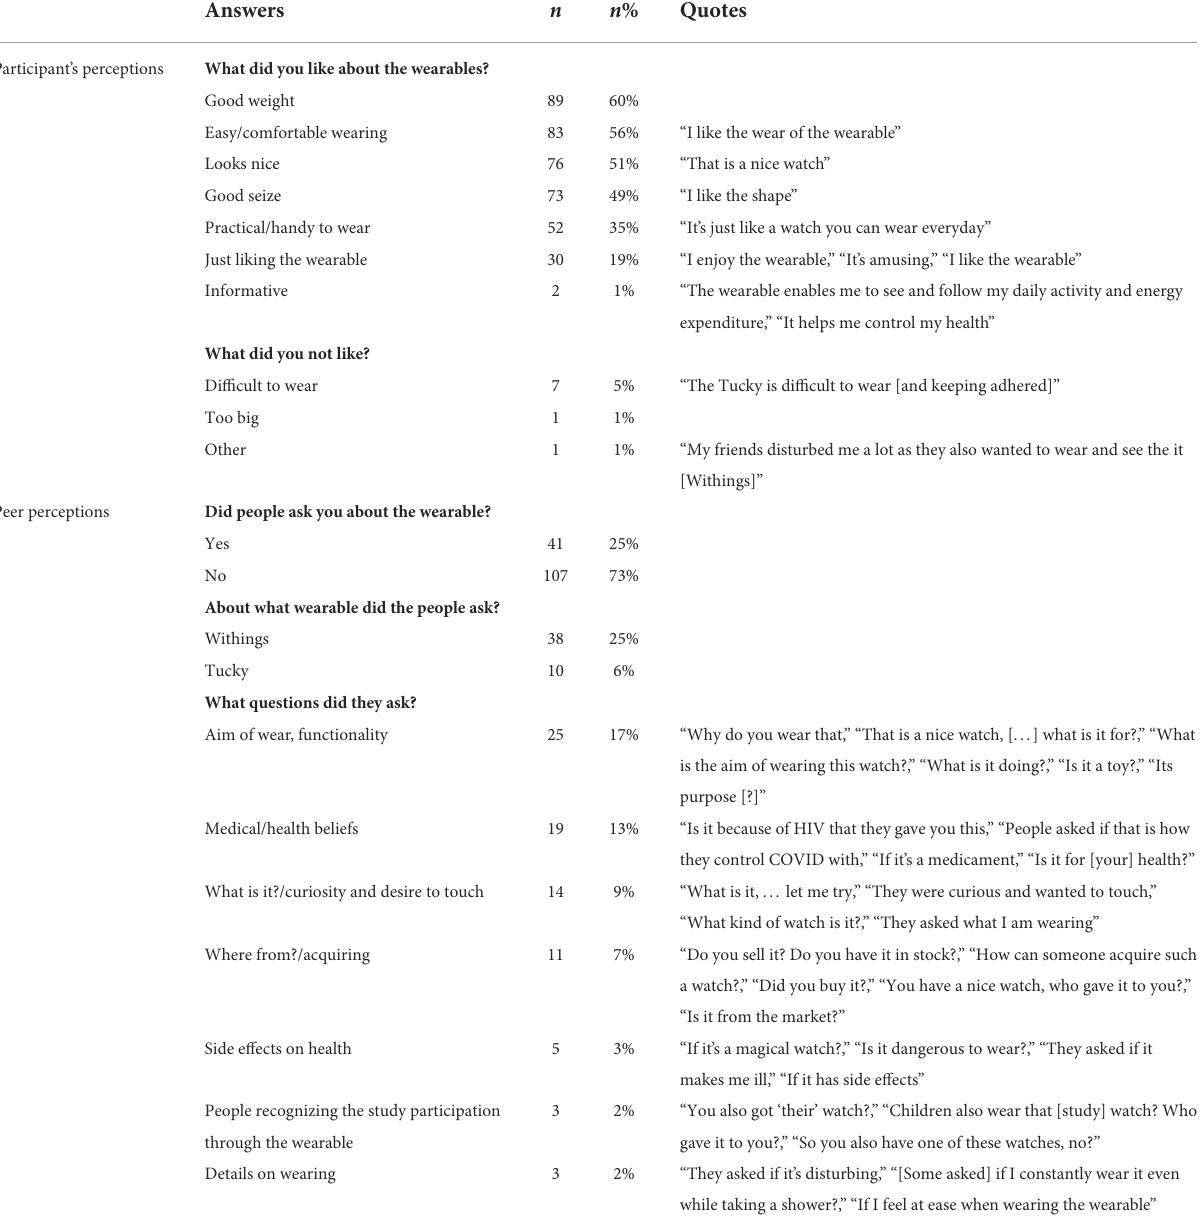
TABLE 3 Overview of key responses to multiple-choice and open-ended questions about perceptions on wearables (of participants and social circle). Answers n n % Quotes Participant’s perceptions